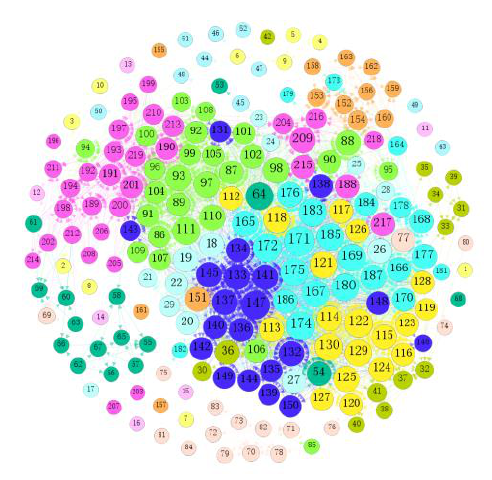
Fig. 1. Hospital referral network I of